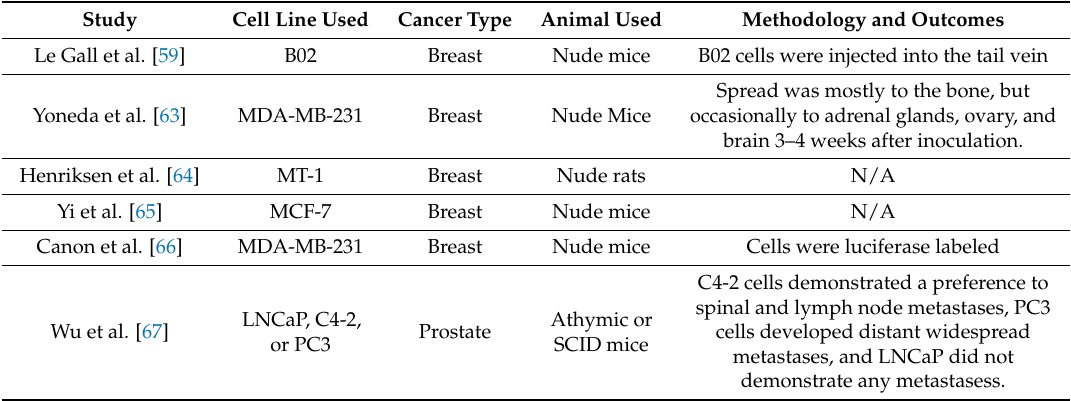
Table 2. Intracardiac/intravenous